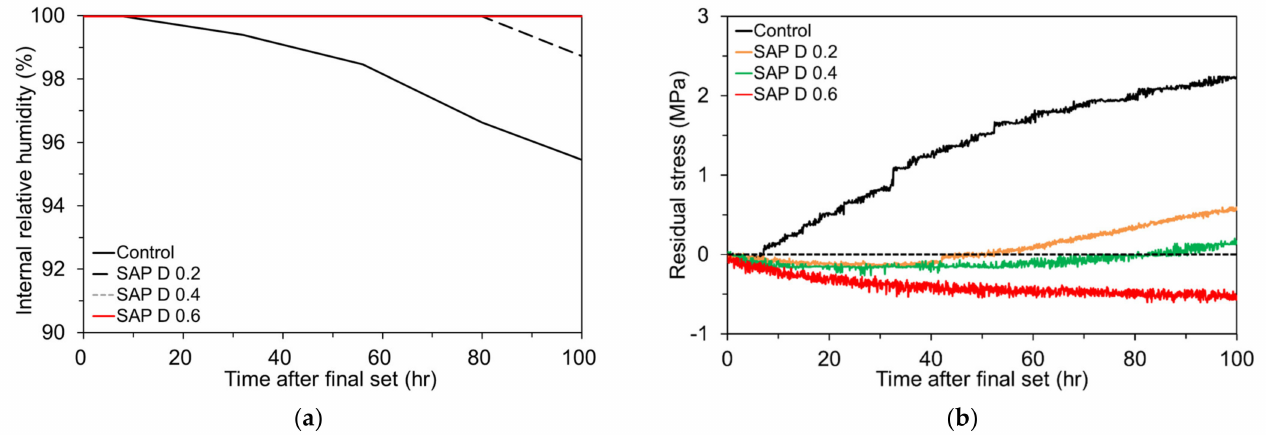
Figure 15. Effect of SAP content on: ( a ) IRH changes; and ( b ) restrained stress